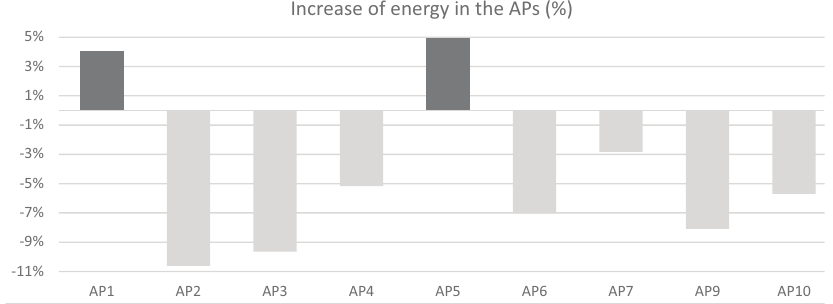
Figure 10. Increase of the energy in the APs after removing AP 8